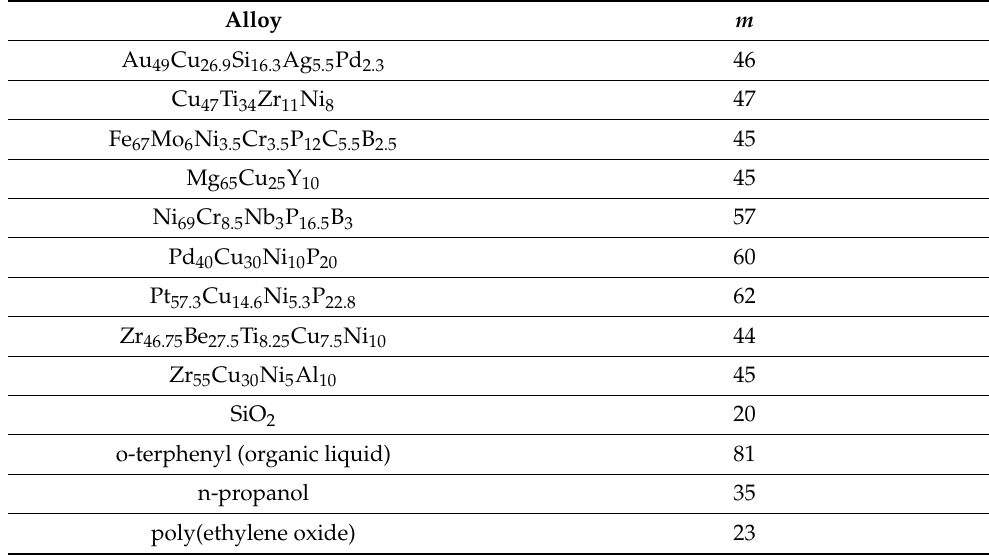
Table 1. Fragility parameters for different substances from Refs. [111,112] rounded to integers.